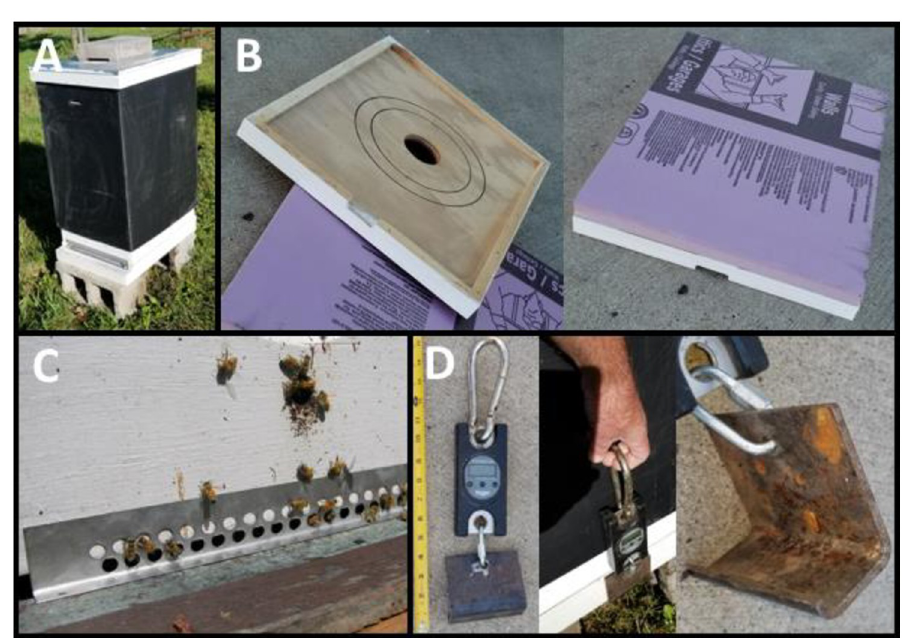
Fig 2. (A) Polypropylene hive cover on a honey bee colony. (B) Inner cover board and insulation that are placed on the top of the hive under the polypropylene cover. (C) Mouse guard on entrance to reduce rodent infestations. (D) Modified postal scale used to weigh